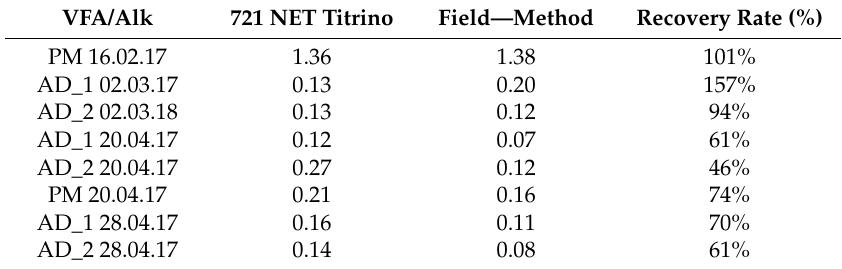
Table A9. VFA to alkalinity ratio, PM—pig manure; AD—anaerobic digestion